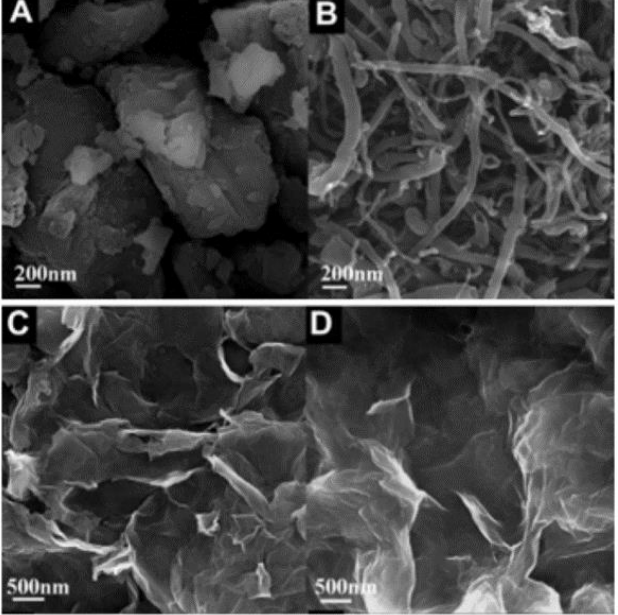
Figure 22. Typical FESEM images of ( A ) fullerenes (C 60 ), ( B ) CNTs, ( C ) graphene oxide, ( D ) solvent-exfoliated graphene. Reprinted from [81], Copyright 2013, with permission from Elsevier.